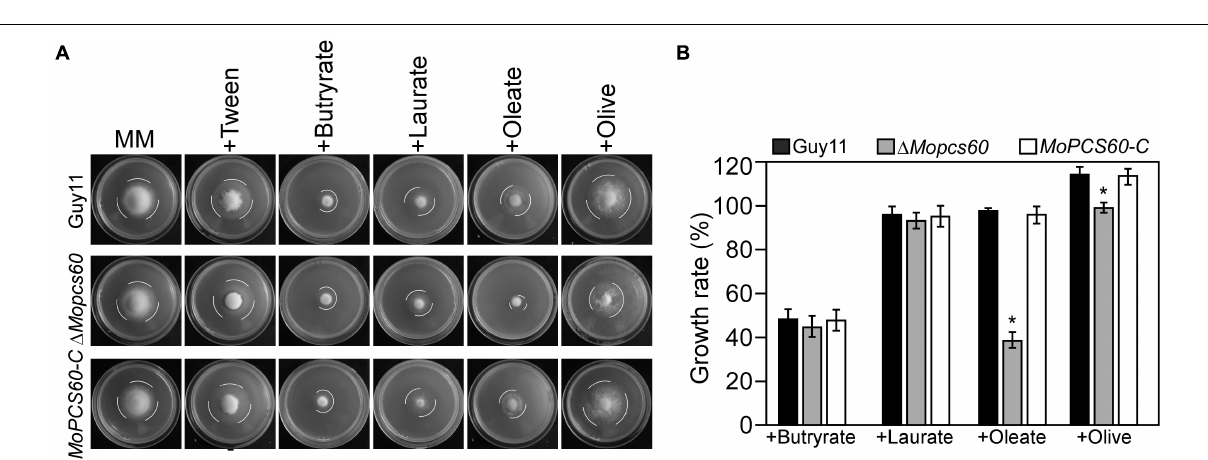
FIGURE 3 | Papillary callose deposits are not changed in the (cid:49) Mopcs60 mutant. (A) Aniline blue staining to visualize appressorium of the wild-type Guy11, (cid:49) Mopcs60 mutant, and the complemented transformant MoPCS60-C at 32 hpi on rice leaves. Bar = 5 µ m. (B) Statistically analyzed the number of papillary callose deposits formed underneath appressoria. Error bars represent the standard deviations of three replicates.